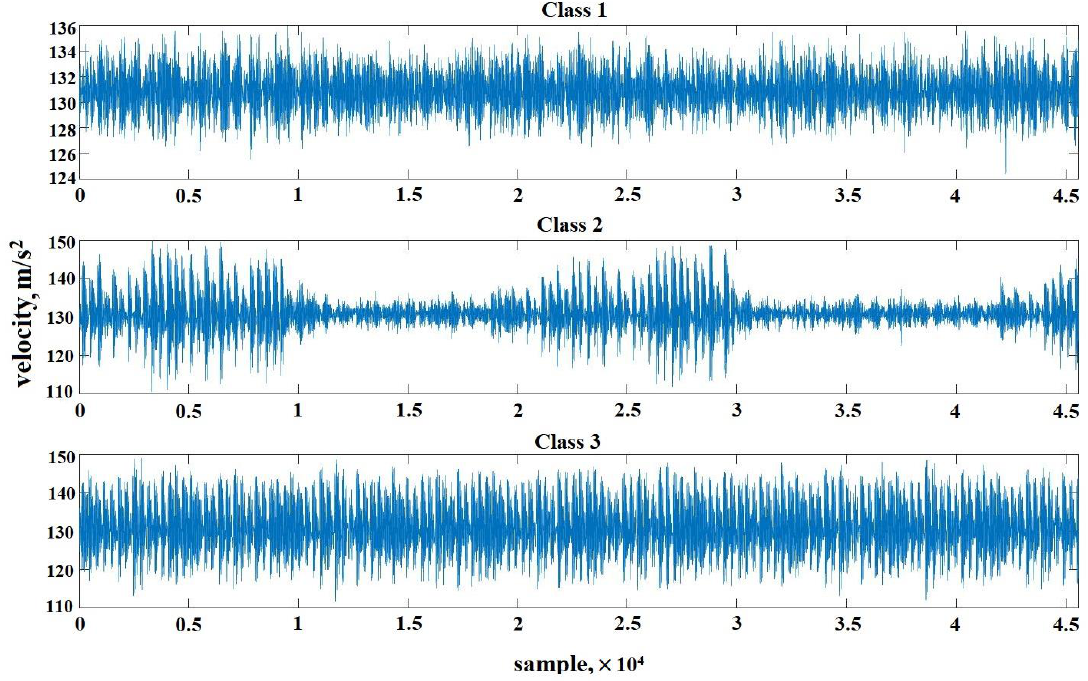
Figure 9. Raw signal with 50,000 samples for each of the classes.